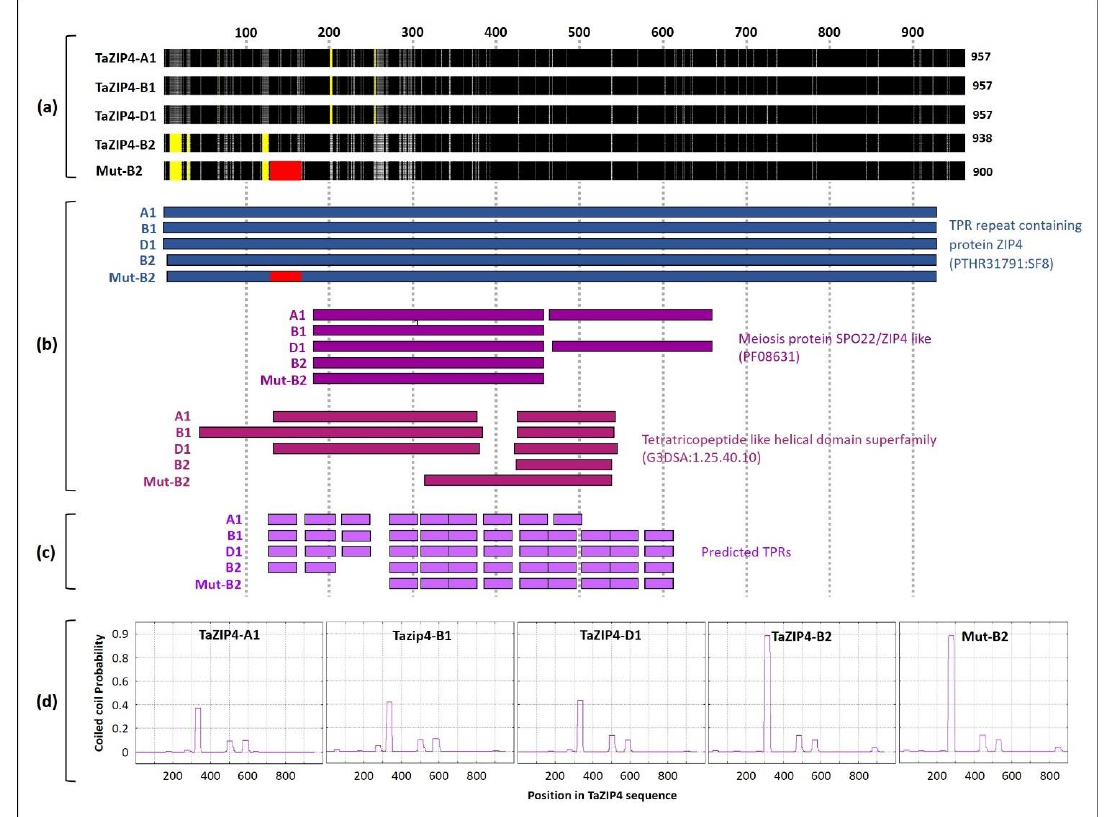
Figure 1. Comparison of the TaZIP4 homoeologous proteins. ( a ) Multiple amino acid sequence alignment of the TaZIP4 homoeologous proteins using ClustalX software (version 2.0; [31,32]). Regions with identical amino acid sequences across the four proteins are in black. Grey colour refers to sequences with similar amino acid properties and light grey refers to sequences with different amino acid properties. Yellow regions indicate gaps in sequence alignment. Mut-B2 refers to Tazip4-B2 in the CRISPR mutant. Red region shows the 38-amino acids segment deleted from the protein of the CRISPR Tazip4-B2 mutant. ( b ) Predicted functional domains in the TaZIP4 proteins using the online InterPro software (version 82.0; [33]). ( c ) Predicted Tetratricopeptide Repeats (TPRs) in the TaZIP4 proteins using the online TPRpred program (version 11.0; [36]. ( d ) Predicted coiled coil domains in the TaZIP4 proteins using the online MARCOIL programme [36,37].